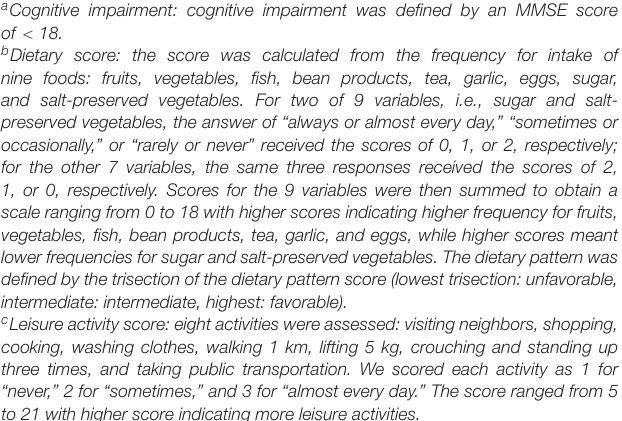
dietary pattern, and with lower leisure activities ( Table 1 , p -values <